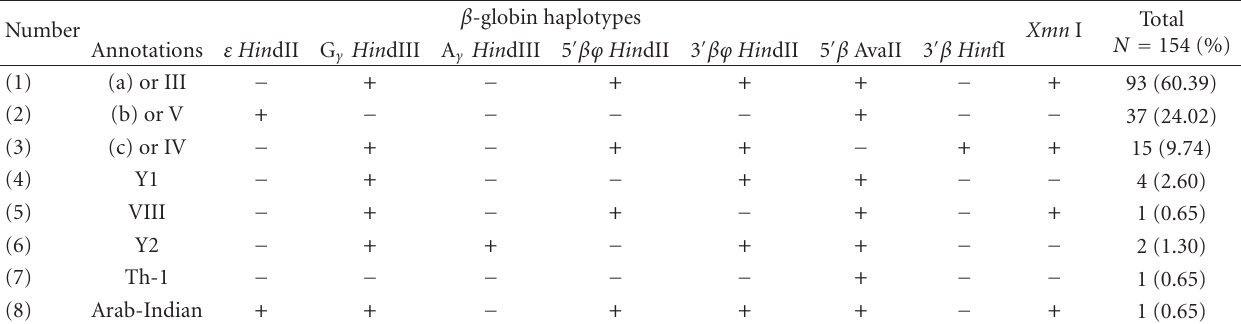
Table 1: Summary of 8 di ff erent β globin haplotypes linked to Hb E alleles from 154 Hb E chromosomes.